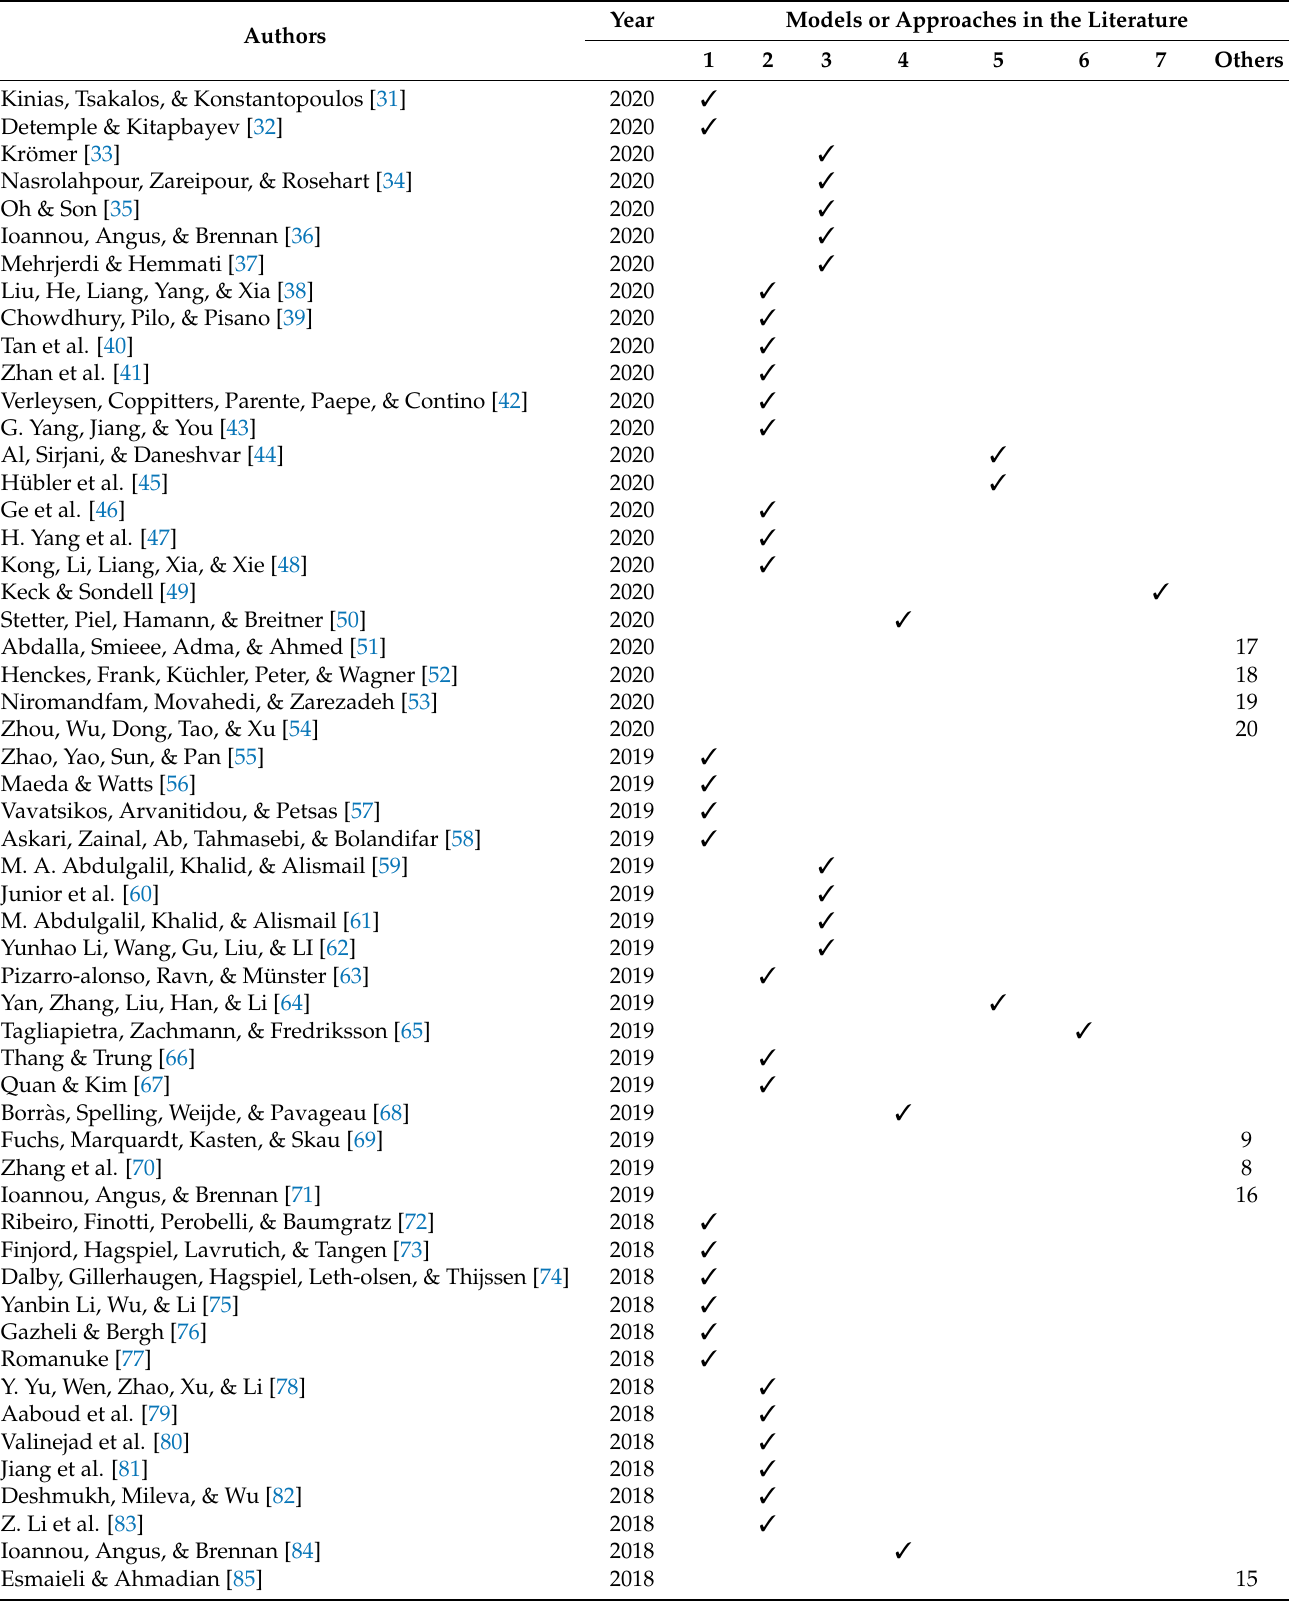
Table 2. Models or approaches used in the